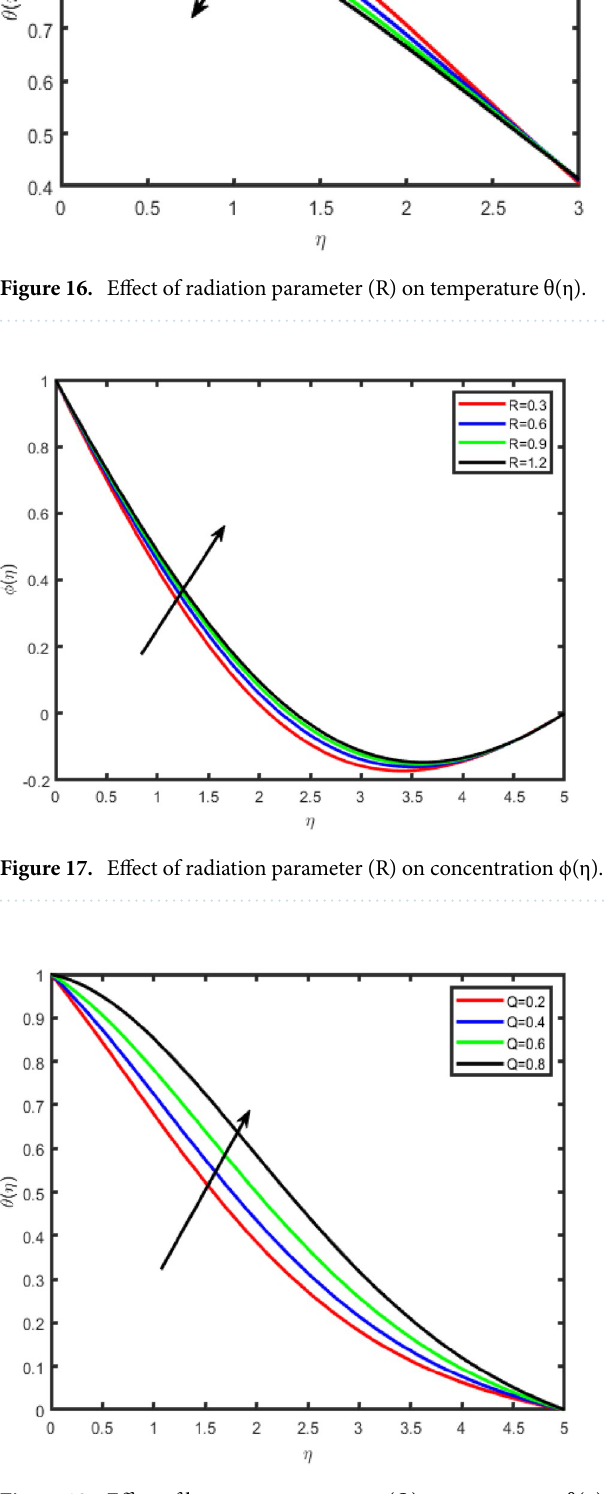
Figure 18. Effect of heat source parameter (Q) on temperature